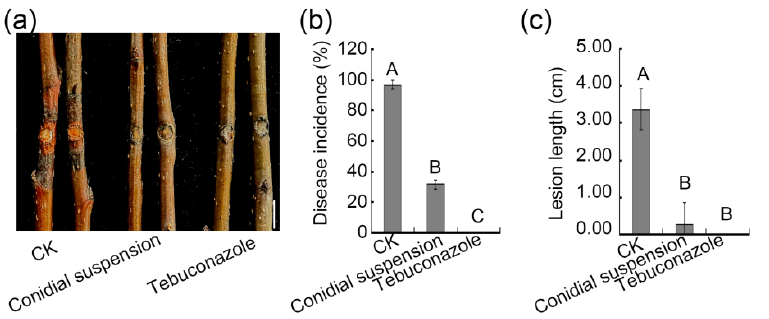
Figure 3. Effect of conidial suspension of ZZ1 on pear Valsa canker disease caused by V. pyri . ( a ) Conidial suspension of ZZ1 suppressed pear Valsa canker. Bar, 1 cm. The picture was taken at 7 days after inoculation. ( b ) Statistical analysis of the disease incidence. ( c ) Statistical analysis of disease lesion length. Values are means ± SD from ten replicates. Letters above the bars indicate statistical significance ( p < 0.01) based on Tukey’s test.